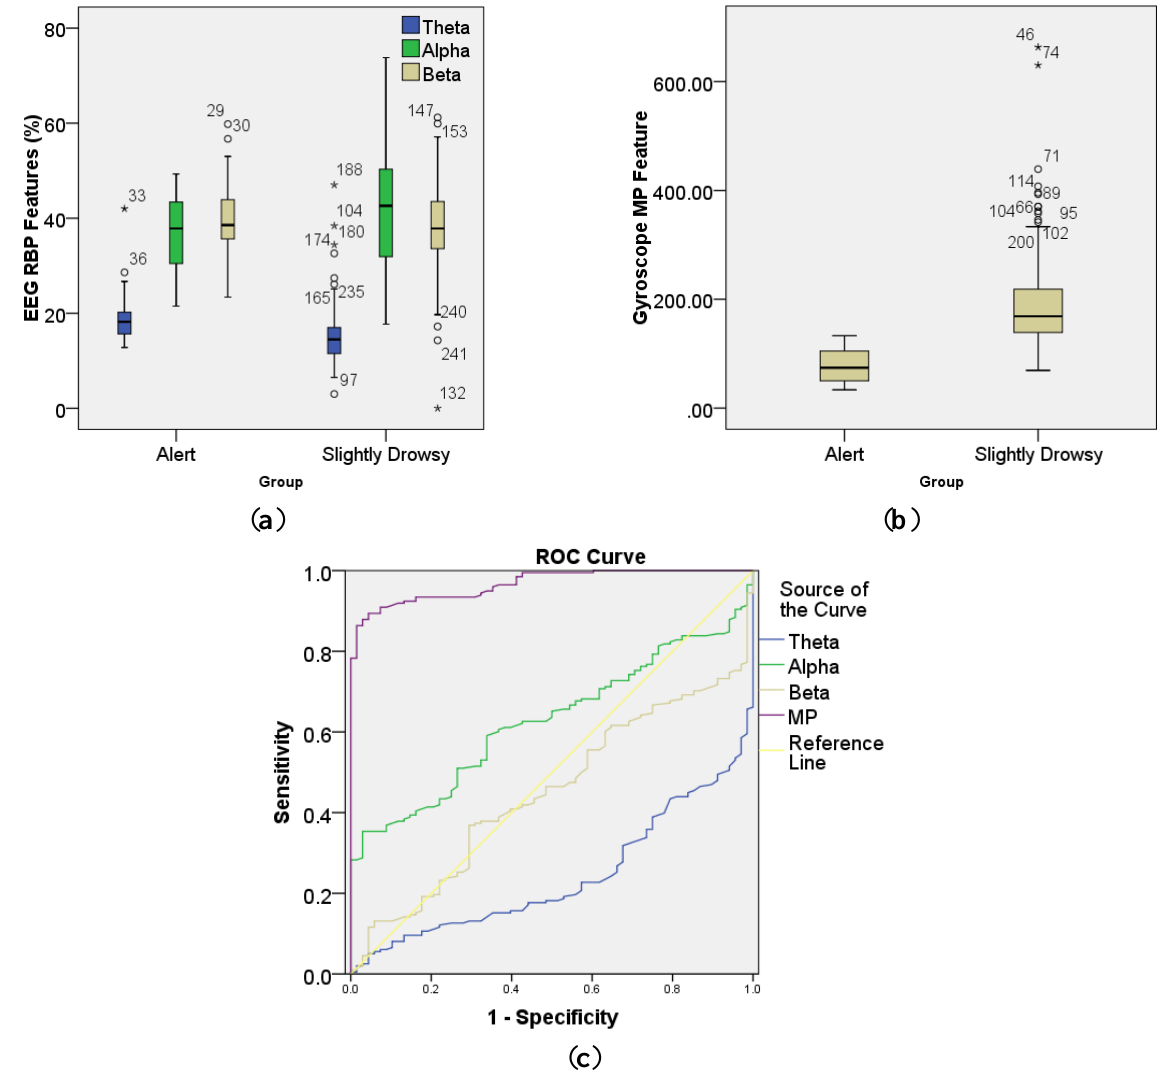
Figure 7. Box-Whiskers plots of ( a ) EEG and ( b ) gyroscope features. The boxes have three lines to present the values for first quartile (the bottom), median, and third quartile (the top) for column data. The length between the first quartile (Q1) and the third quartile (Q3) is called interquartile range (IQR). Two addition lines at both ends of the whisker indicate the Q1 − 1.5 × IQR and Q3 + 1.5 × IQR value of a column data. Any data not included between the whiskers is plotted as outliers represented by “o” for mild outliers and “*” for extreme outliers. The number next to the outlier is the number of the data in that column, called case number; ( c ) ROC curve showing sensitivity (possibility of true drowsy event) and 1-specificity (possibility of false drowsy event) for extracted EEG and gyroscope